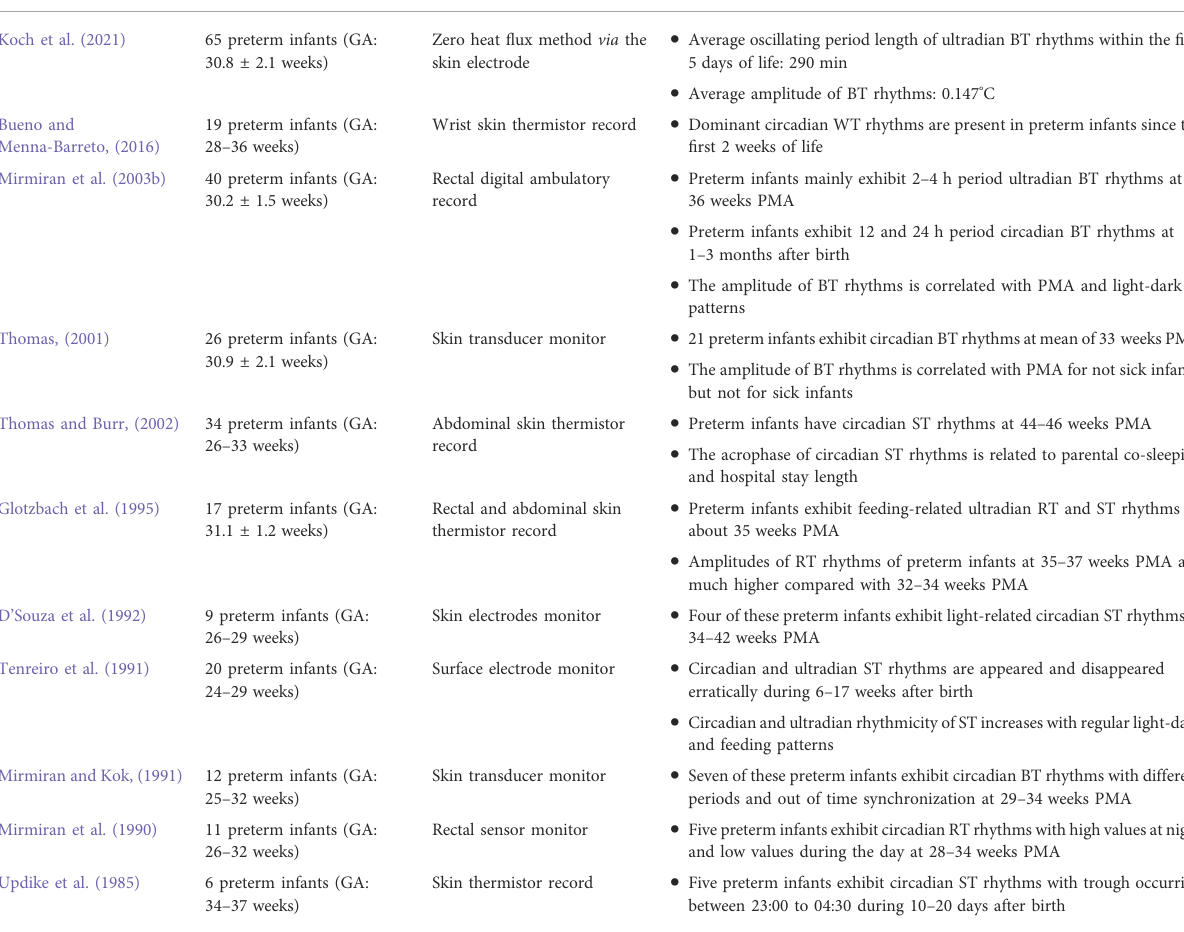
TABLE 3 Studies about the body temperature rhythms in preterm infants. Studies